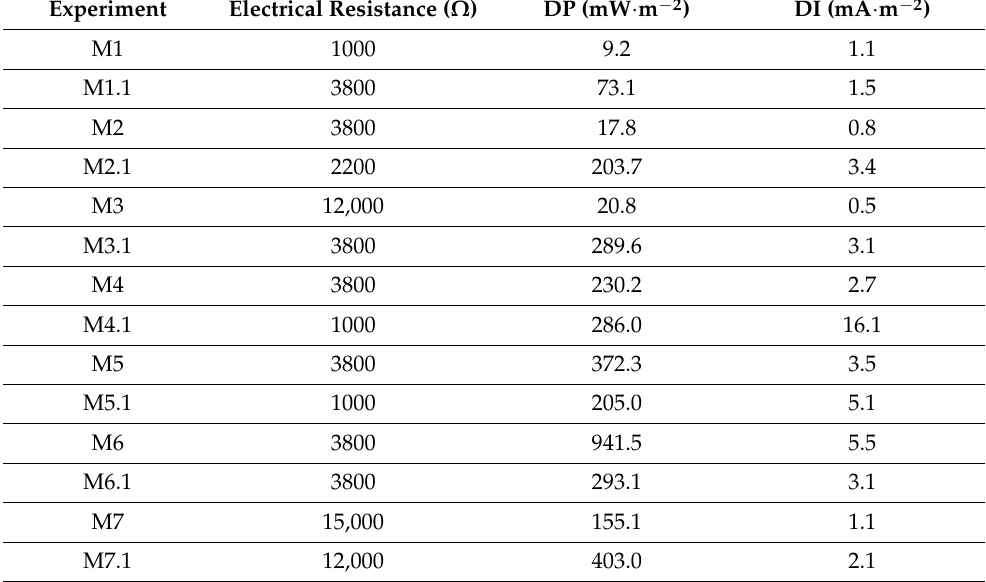
Table A1. Results of polarization curves: maximum potential (DP and DI) for each electrical